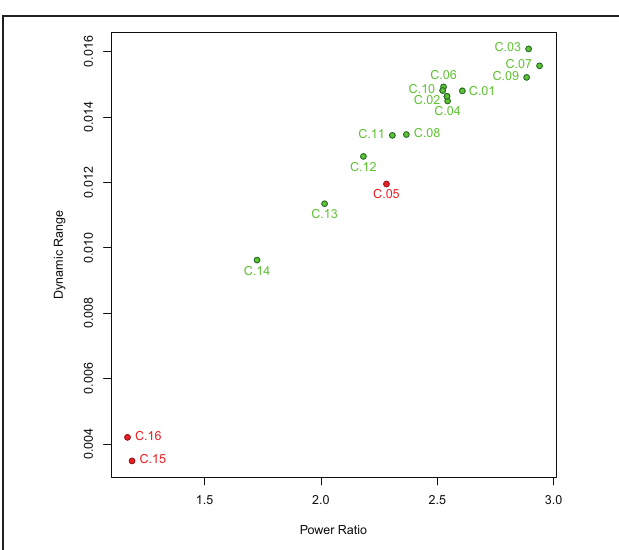
FIGURE 5 | Power ratio and dynamic range of the components identified. Gray matter components are shown in green, artifact components in red. Both power ratio and dynamic range are highest for gray matter networks and lower for artifactual components, though with some overlap since the most consistent of the artifact components, C.05, has higher power ratio and dynamic range than the two least consistent gray matter components, C.13 and